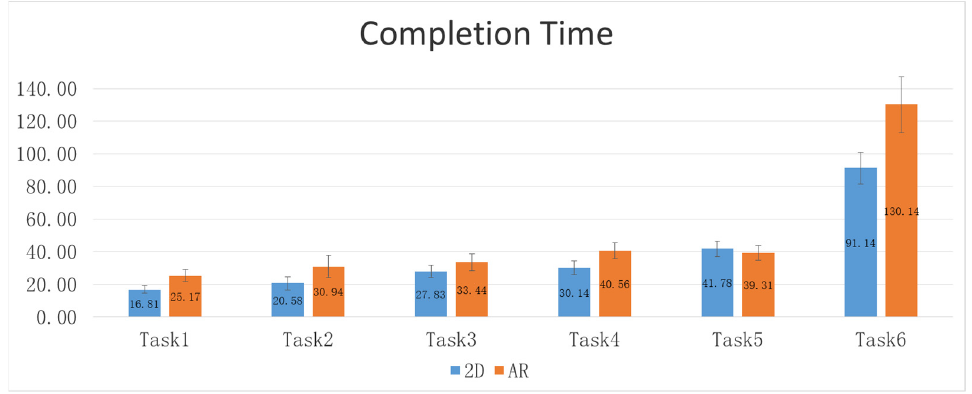
Figure 6. Completion time (seconds) for the six tasks with the 2D graph and the AR graph.